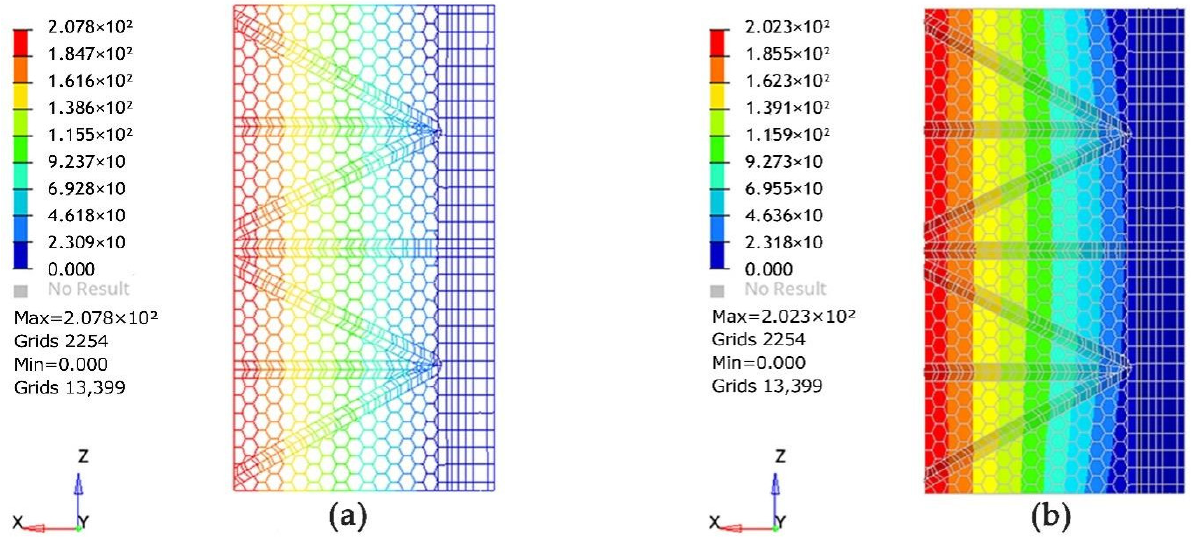
Figure 12. Numerical plots of model II stiffness for permanent loads. ( a ) Deflection diagram under self-weight of model II skeleton structure. ( b ) Deflection diagram of model II skeleton with membrane fabric under self-weight.